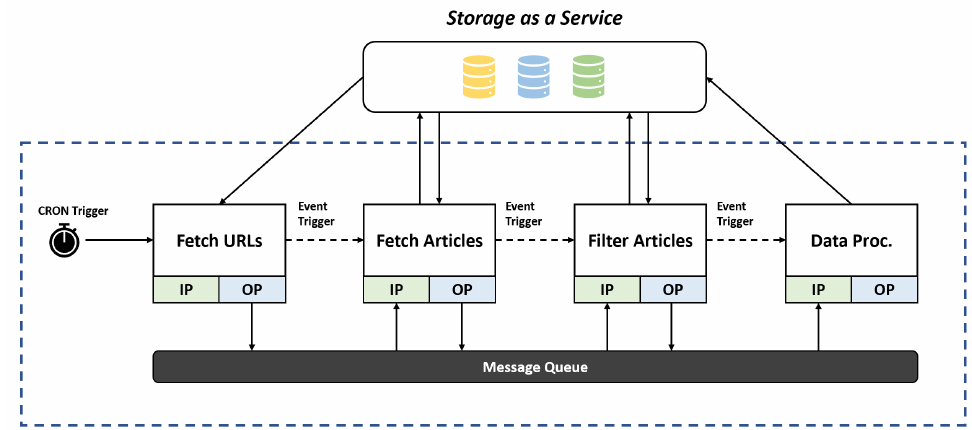
Figure 6. Example data pipeline used in the experiments.